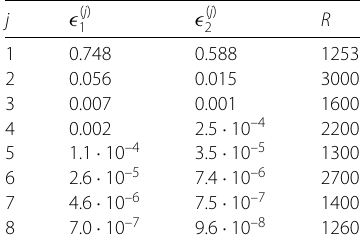
Table 3 (cid:15) ( j ) , (cid:15) ( j ) , j = 1, ... , N and the respective Rayleigh number R in which the maximum takes place 1 2 for different dimensions j of the reduced basis space. R is in the interval [1253;3000] for solutions S 3